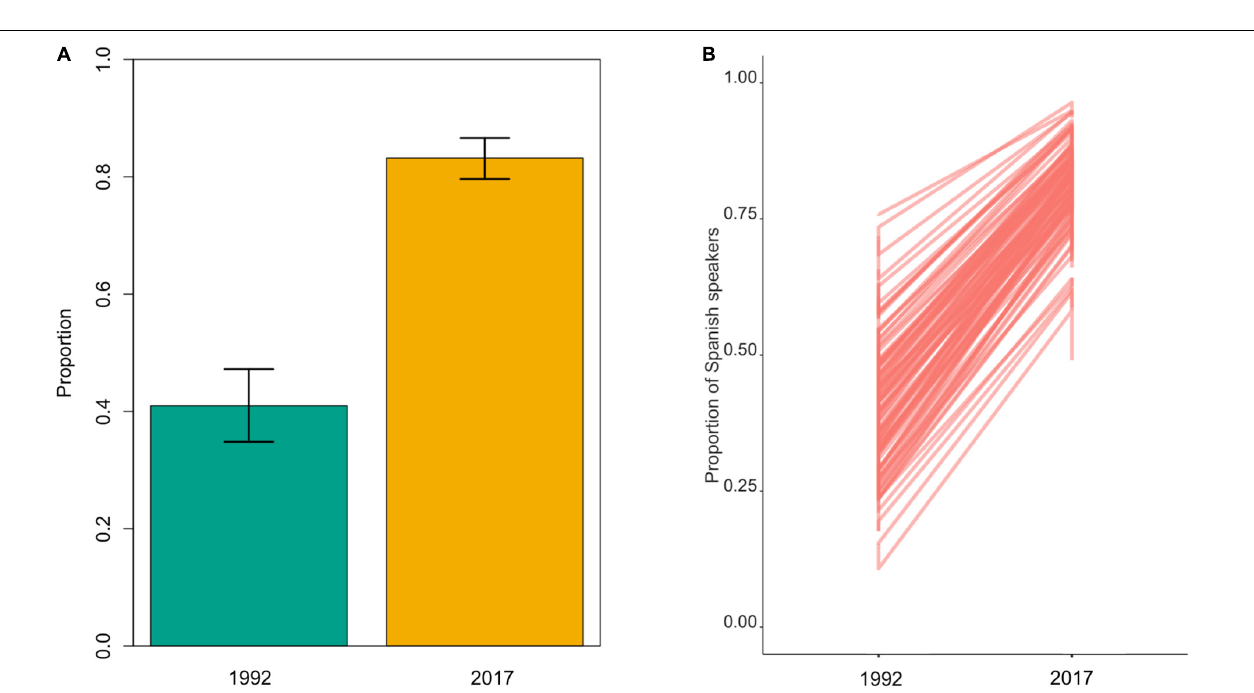
FIGURE 1 | Adapted from https://ultrabpm.wordpress.com, the household-level social network measures used in the present analyses is shown. “h” represents the node with the highest betweenness centrality, “d” that with the highest eigenvector centrality (EC), and “j” that with the highest degree centrality. Unlike the networks in our study, the connections shown in the figure are not directed, meaning that there is no distinction between in- and out- degree.